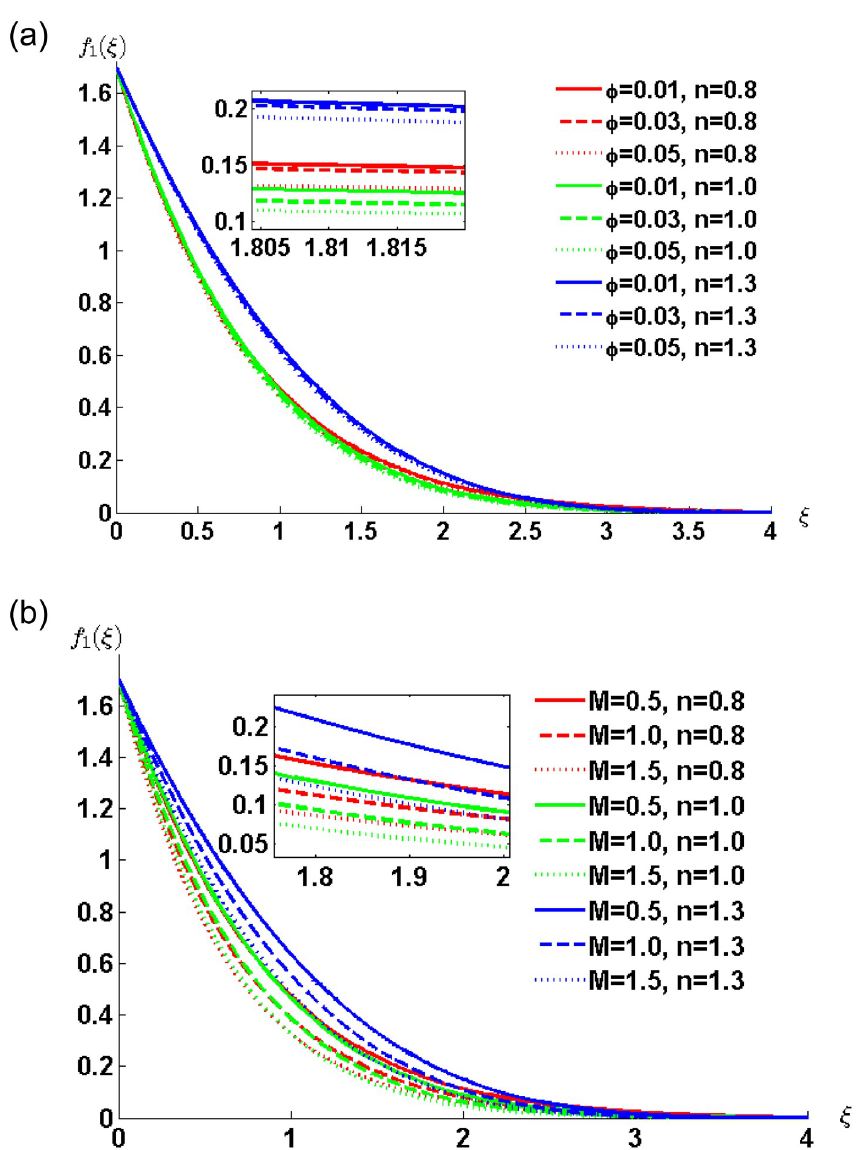
= 8933, ρ = 997.1 σ = 5.5 × 10 − 6 and σ s f s